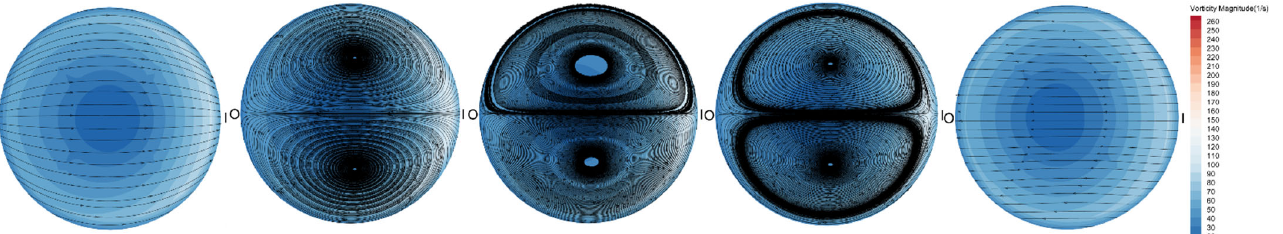
Figure 17. The vorticity magnitude and the projected streamlines at the five sections of the U-shaped channel. The inlet velocity of 0.5 m/s. The temperature boundary condition is: 300 K on the wall and 283 K of the incoming fluid at the inlet.